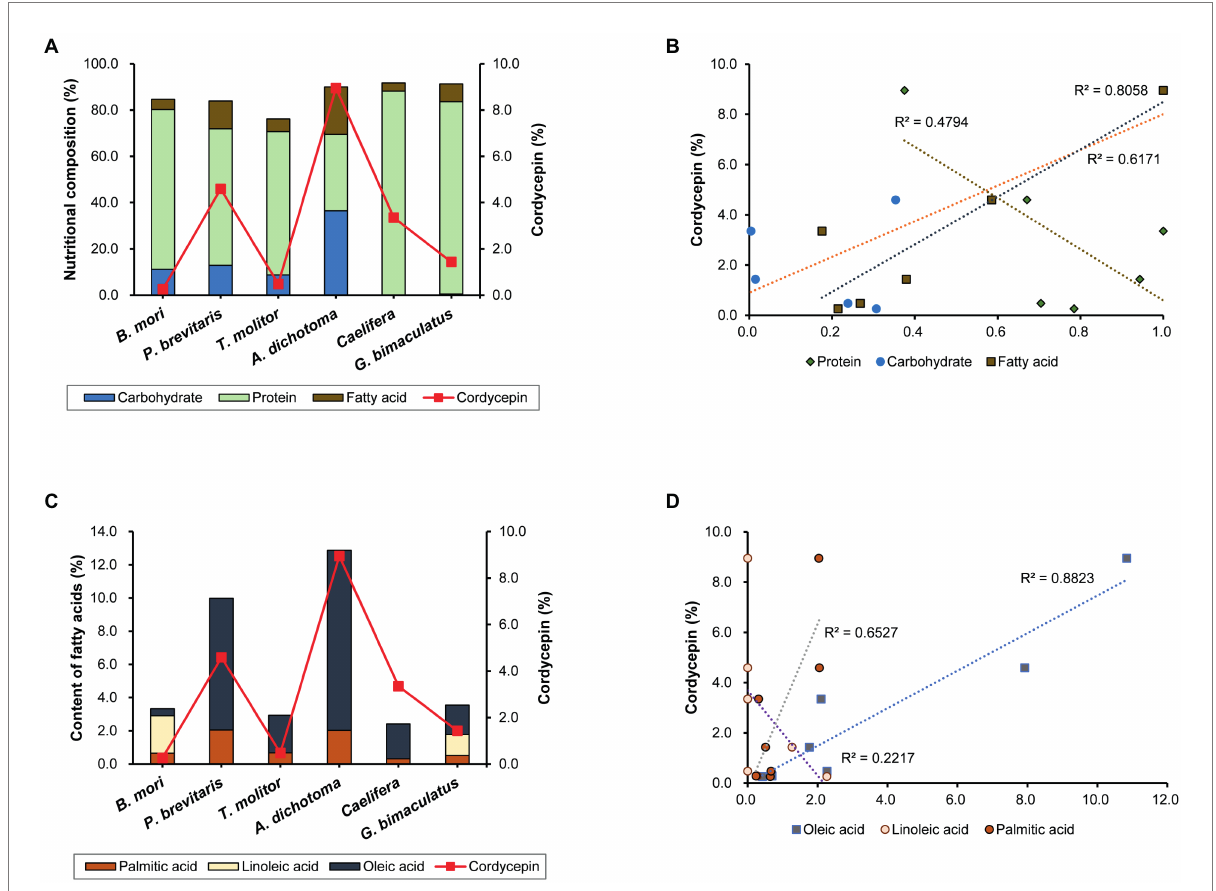
FIGURE 2 (A) Nutritional composition of each insect and cordycepin content, (B) correlation between the content of each nutrient and cordycepin content, (C) content of each fatty acid and cordycepin content, and (D) correlation between the content of each fatty acid and cordycepin